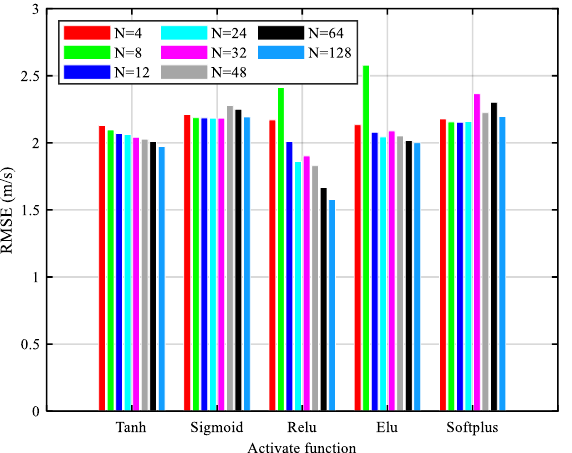
Figure 4. Comparison of different activation functions.